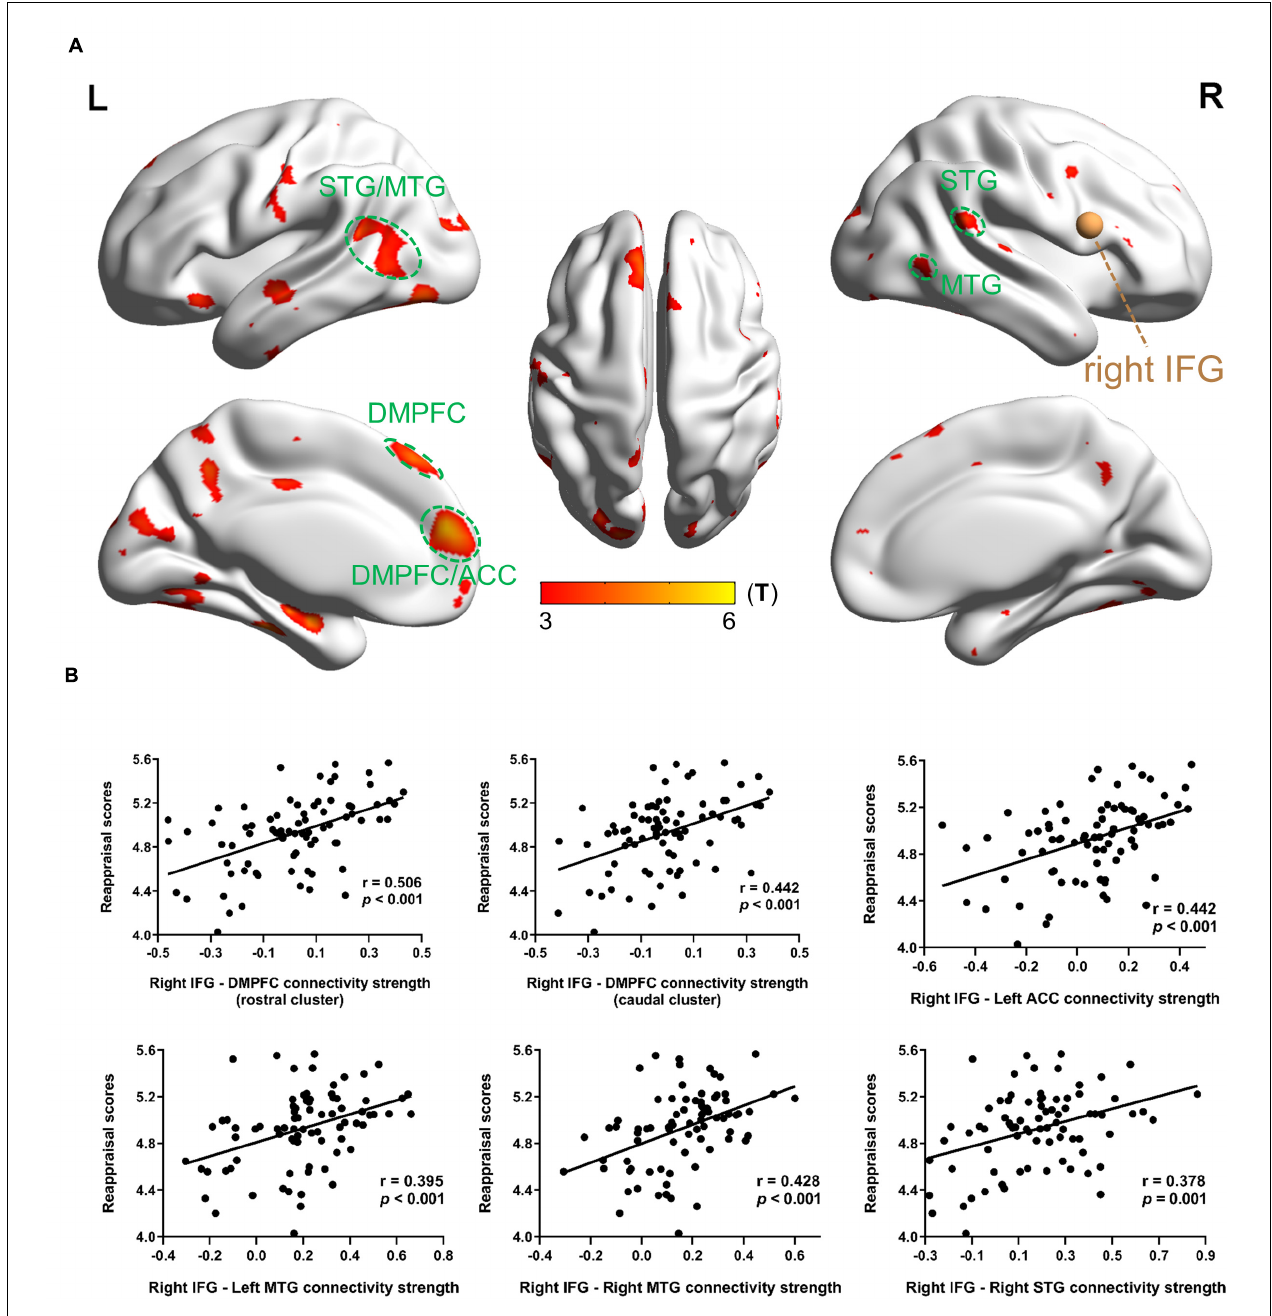
FIGURE 3 | Results of the right IFG-based rsFC related with dispositional use of reappraisal in MRG. (A) Brain regions whose rsFC correlated with reappraisal scores. The brown sphere represented the seed region, and the green circles were drawn to display the ROIs. (B) Partial regression scatter plots depicted the correlation between functional connectivity strength and reappraisal scores. Statistical threshold of false discovery rate P FDR < 0.05 was used for cluster